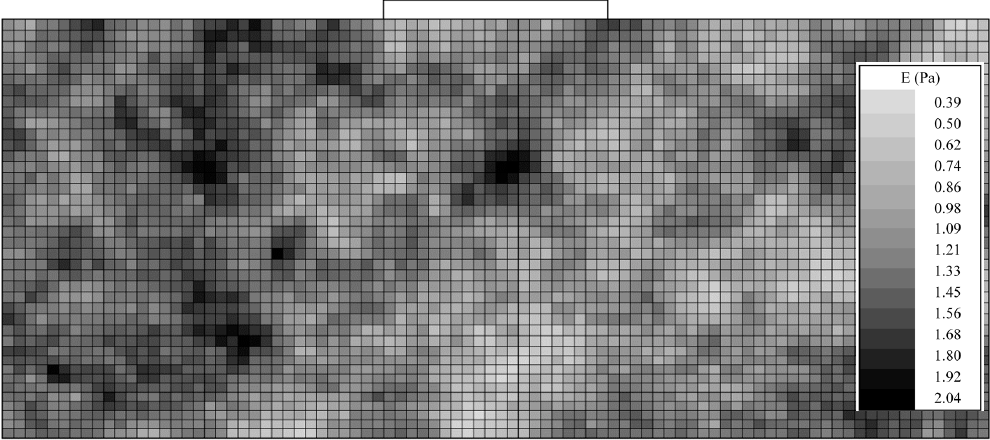
Figure 11. Graphical representation of the random field of E of Example #2 ( θ / B = 0.5; see Table 1).